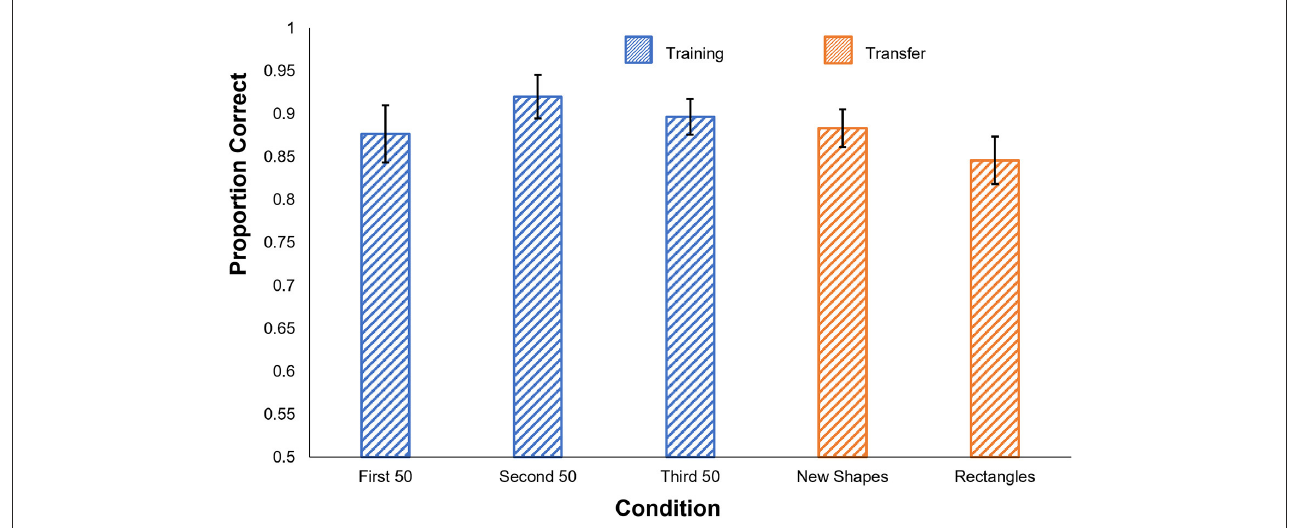
FIGURE3 Human results in Experiment 1c. Proportion correct is shown by condition. Blue: performance in the training phase, separated into 50-trial blocks. Orange: performance on the generalization tests. Error bars show ± one standard error of the